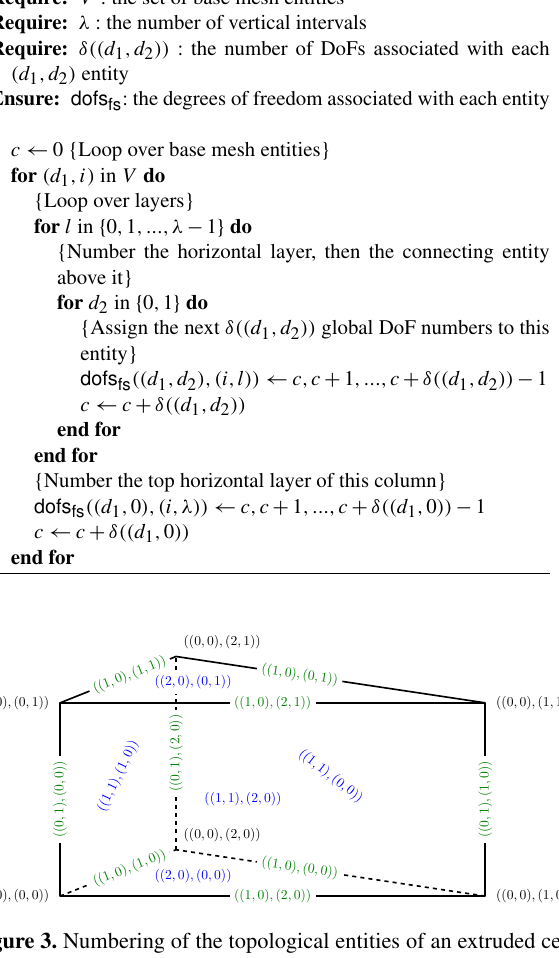
Figure 3. Numbering of the topological entities of an extruded cell for the case of an extruded triangle. The cell itself has number- ing (( 2 , 1 ),( 0 , 0 )) (not shown); the other entities are numbered as shown with vertices in black, edges in green, and faces in blue.